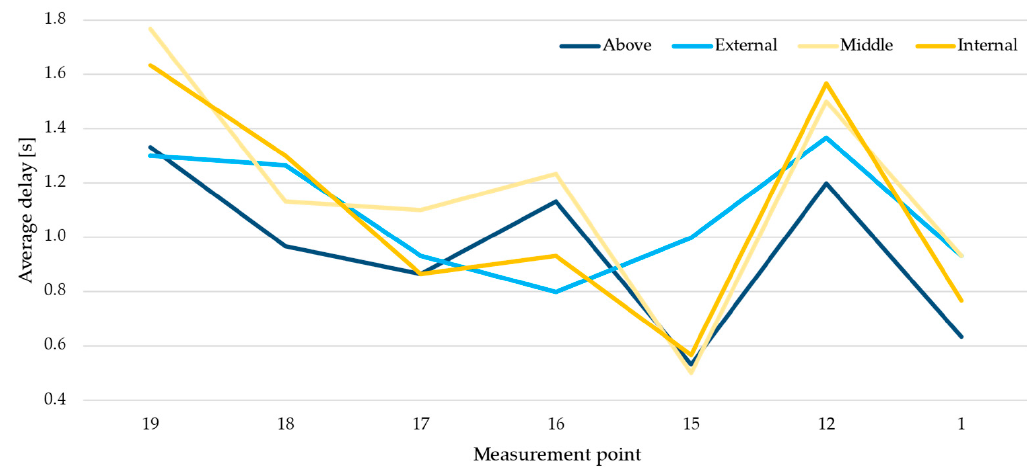
Figure 9. Recorded average delays, according to the tag position. For completeness, Figure 10 below plots the real route taken in the lab (yellow line) during the execution of the experiment and the routes computed by the RTLS system in the best (light blue line) and the worst performing case (blue line). The blue and light blue bullet points represent the coordinates estimated by the RTLS tag, while the corresponding trolley location is given by the closest yellow bullet point; the distance between the yellow and (light) blue points is proportional to the delay given by the RTLS system.